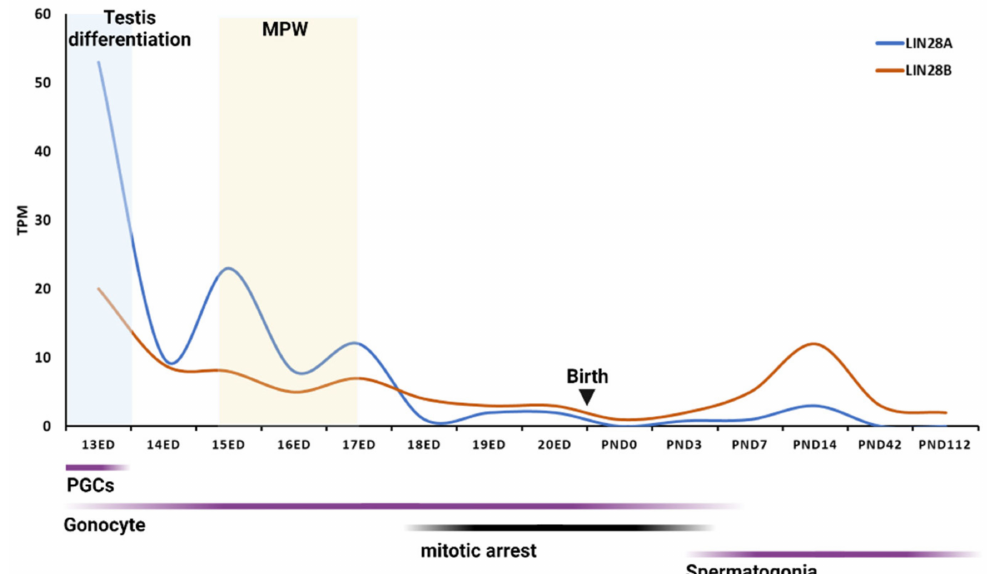
Figure 1. mRNA expression of Lin28ab across rat testis development. Expression levels of Lin28ab mRNAs are shown in transcripts per million (TPM). MPW—masculinization programing window. Data available free online [58,59]. Graph created with BioRender.com (accessed on 4 May